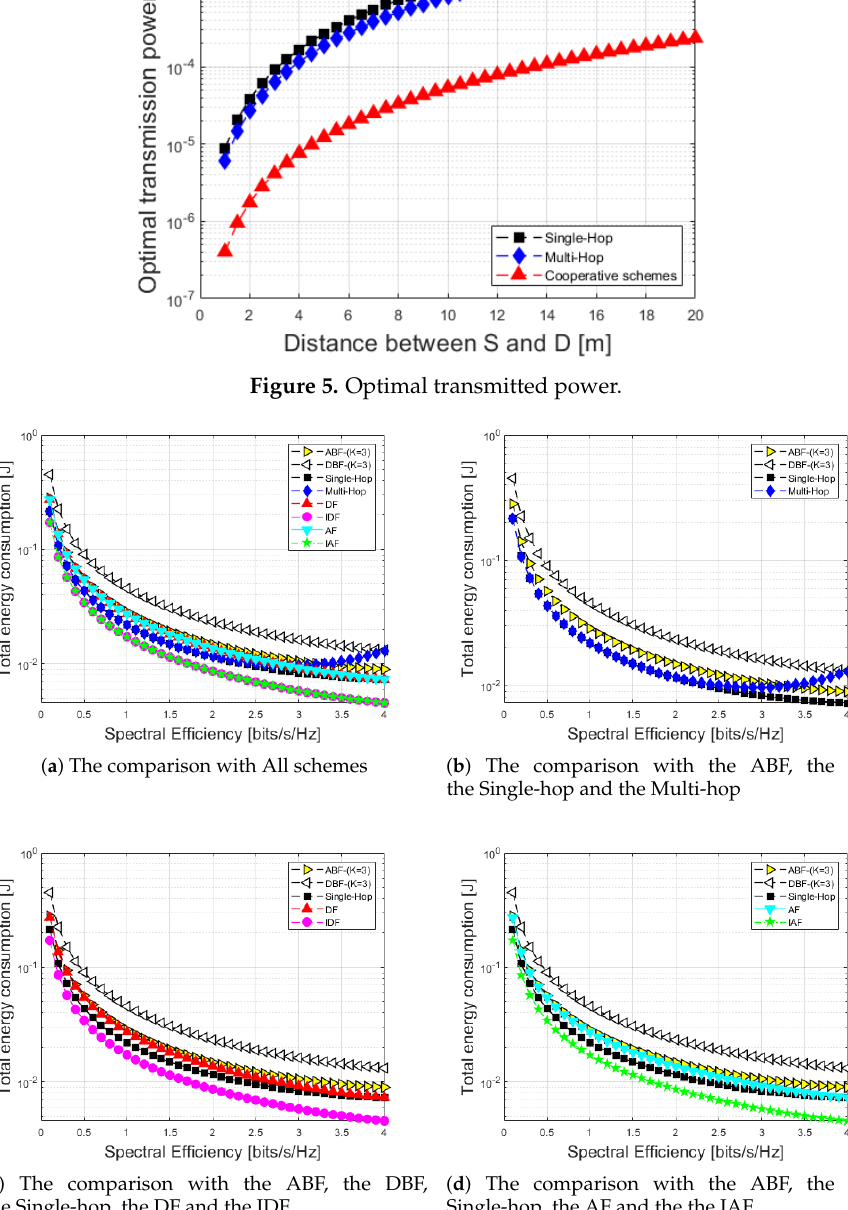
Figure 6. Spectral efficiency vs. total energy